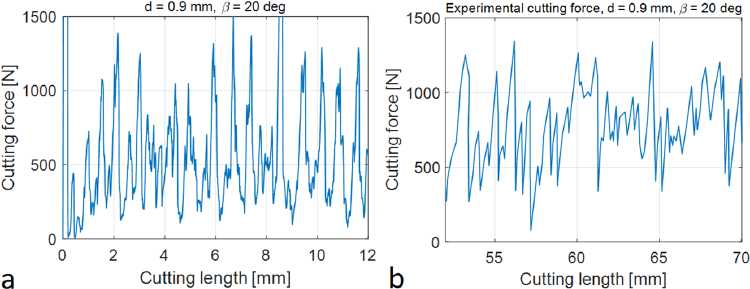
Figure 6. Simulation results for PDC cutting ( d = 0.9 mm, β = 20°): ( a ) predicted cutting force vs. cutting length; ( b ) experimental cutting force vs. cutting length (graph reproduced by estimation from the original graph in [4]).